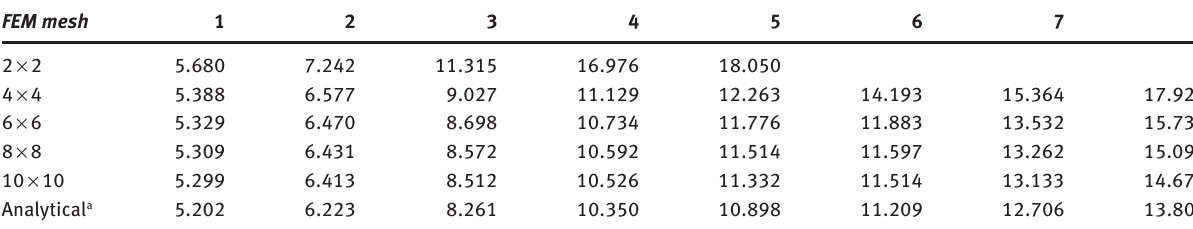
Table 5: Convergence pattern of frequency parameter λ ω π ρ = 2 2 ( / ) / b